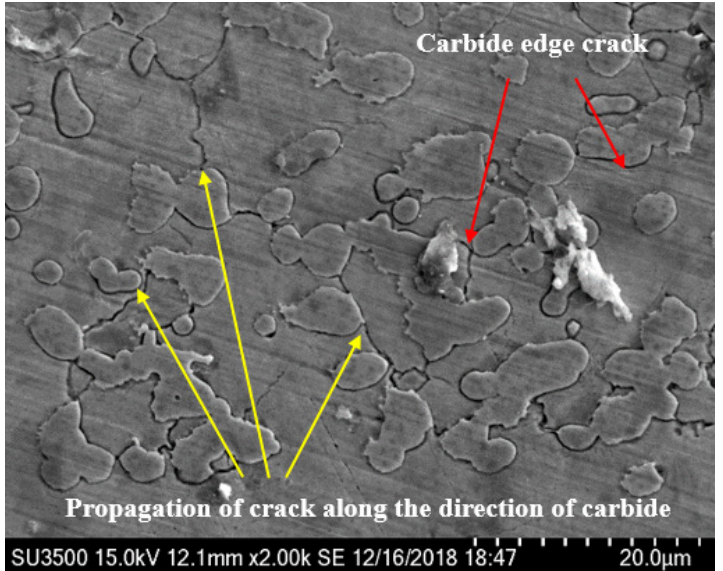
Figure 16. Micromorphology of water droplet erosion zone of stellite alloy. (×2.0 k).